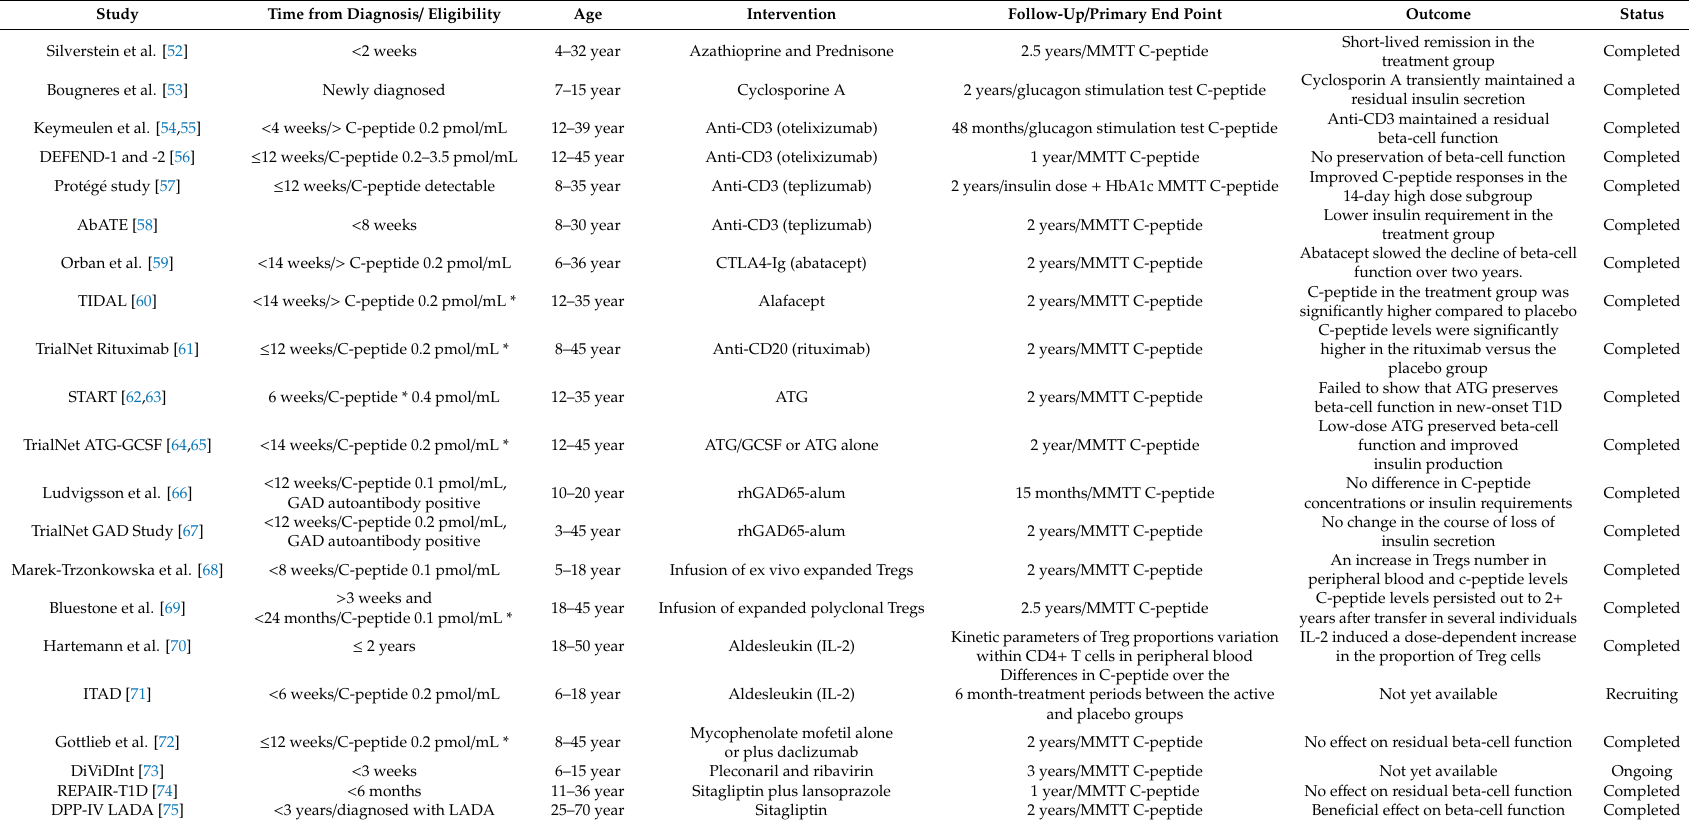
Table 4. Tertiary prevention trials in